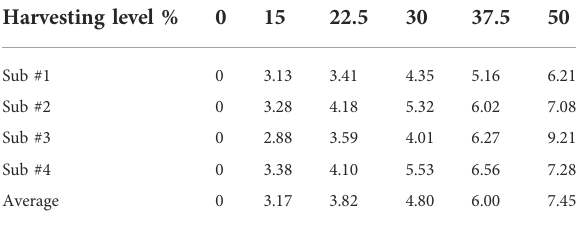
TABLE D2 Electrical power produced at each harvesting